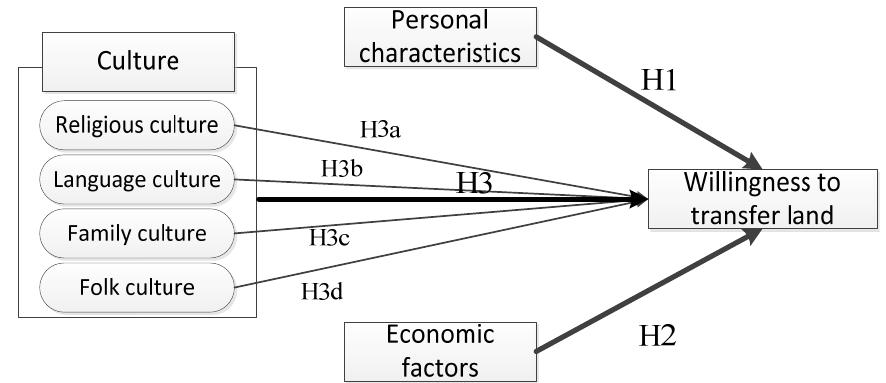
Figure 1. Conceptual framework model and research